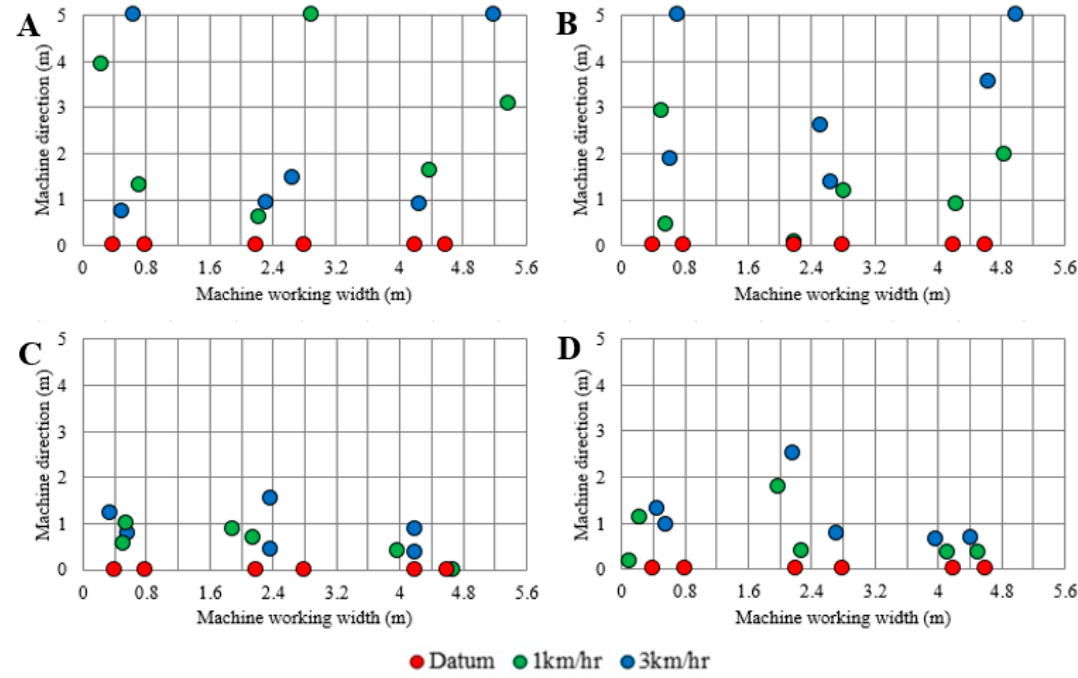
Figure 4. Average trackers movement at different rotary harrow working conditions where: ( A ) at level bar of zero and depth of 6 cm, ( B ) at level bar of zero and depth of 10 cm, ( C ) at level bar of 10 cm and depth of 6 cm, and ( D ) at level bar of 10 cm and depth of 10 cm.